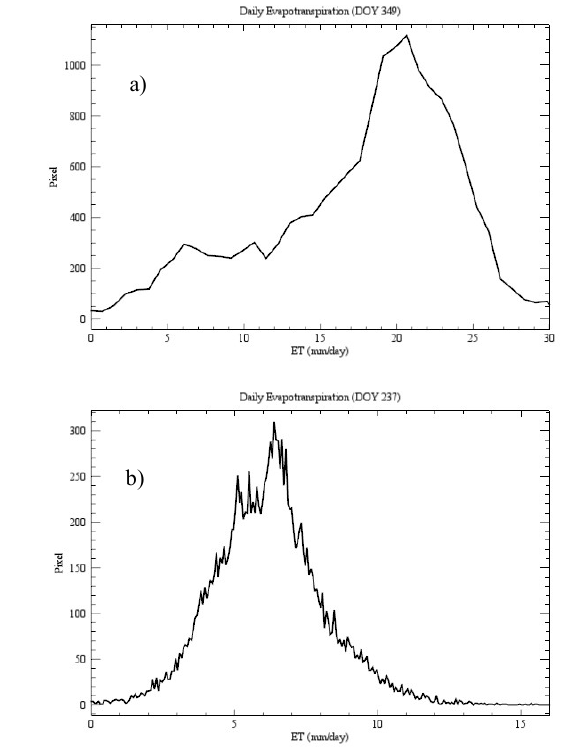
Figure 7. Daily evapotranspiration (mm/day) graphic distribution for Pampa Biome a) in summer season (DOY 349) and b) in winter season (DOY